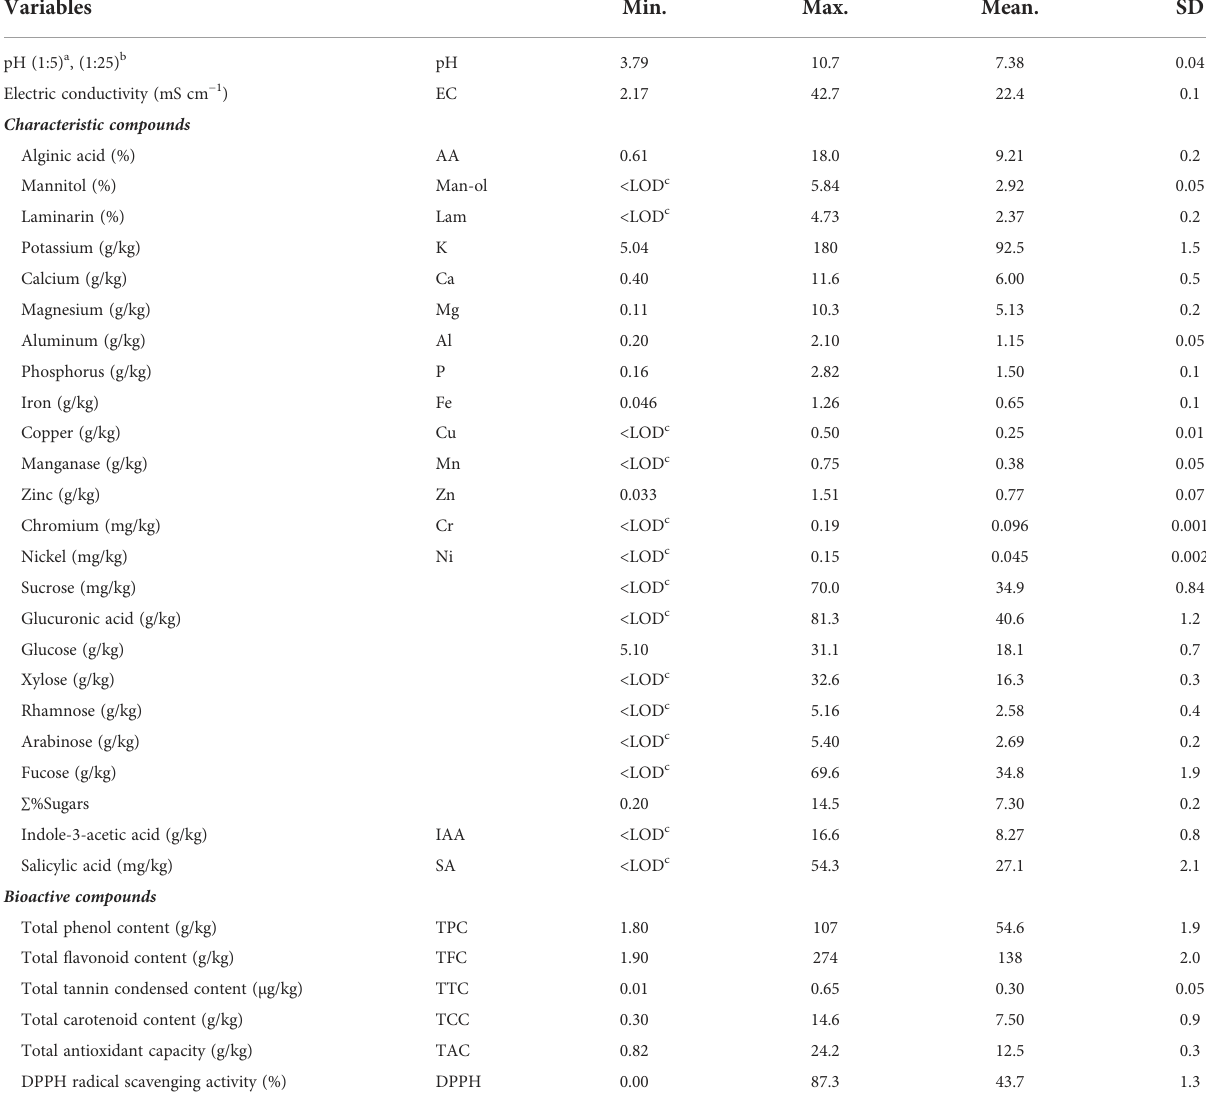
TABLE 2 Summary of the compounds analyzed in seaweed extracts under study. Variables